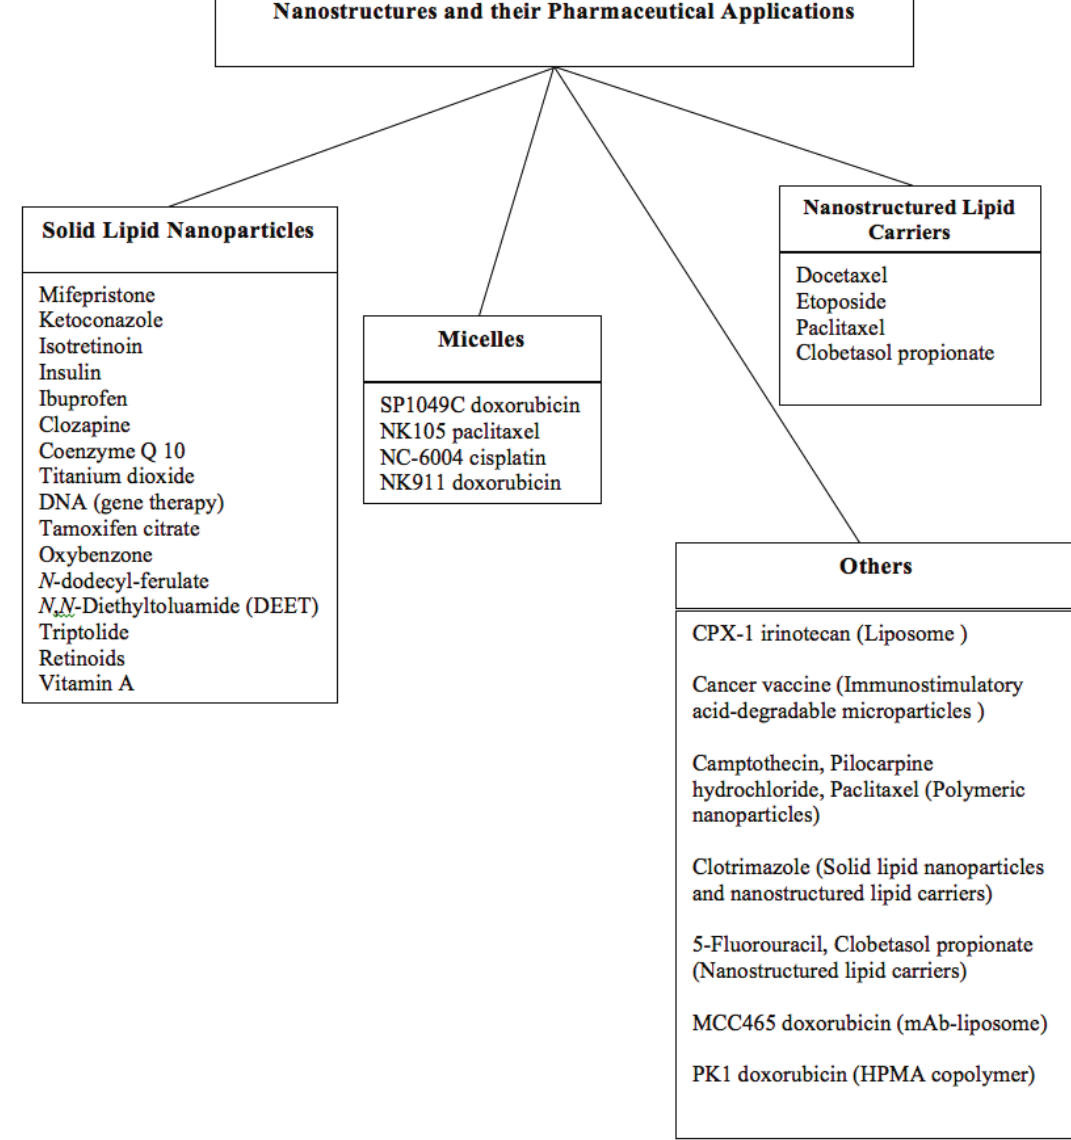
Figure 1: Nanomaterials and their application in